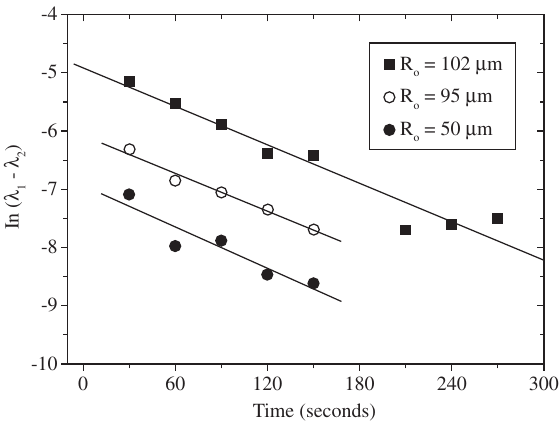
Figure 3. The change in the SAN droplet rectraction dimensions as function of the time. and geometric means calculated values, as already shown by Wu 16 in several polymer pair systems (PEO/PDMS, PVAc/PDMS, PCP/ PDMS, PCP/PnBMA, PCP/PS, PMMA/PNBMA,